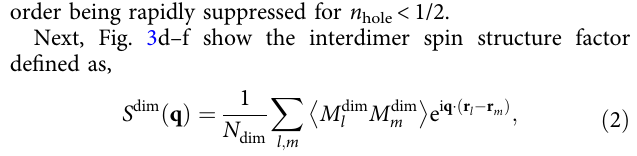
stable VMC simulations are dif fi cult unless additional Weiss fi elds that induce long-range CO are introduced in | Φ 〉 . Fermi surface and spin structure factor . The electron-hole doping asymmetry is closely related to the shape of the FS and the interdimer magnetic fl uctuations. Figure 3a – c show the non- interacting FS for n hole = 2/3, 1/2, and 1/3. As n hole increases from 1/2 (hole doping), the FS shifts toward the right and left edges of the fi rst Brillouin zone (M-X line in Fig. 3b). Since the energy gap of the DAF order opens along the Brillouin zone edge 11 , the DAF order becomes more favored for hole doping. For n hole = 2/3, the FS almost touches the Brillouin zone edge, and there the DAF (cid:3) 2 : 5, as shown in Fig. 2a. Note region extends down to U = t b 1 that the Fermi energy is located in the vicinity of van Hove sin- gularity at n hole = 2/3 as shown in Fig. 1b. Around this hole density, anomalous behavior such as pseudogap phenomena is naively expected 46 . In clear contrast, the FS departs from the M-X